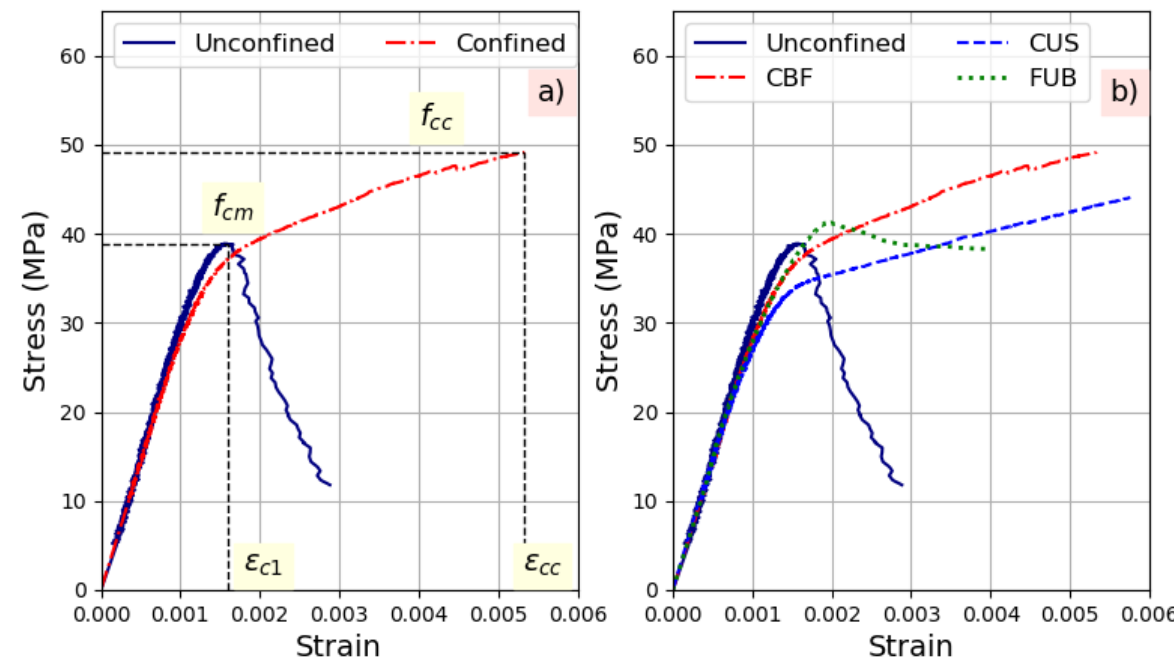
Figure 2. Behavior under compression tests of strengthened reference concrete C30R-30R: ( a ) Schematic stress–strain curve and main parameters, ( b ) Experimental compressive behavior.